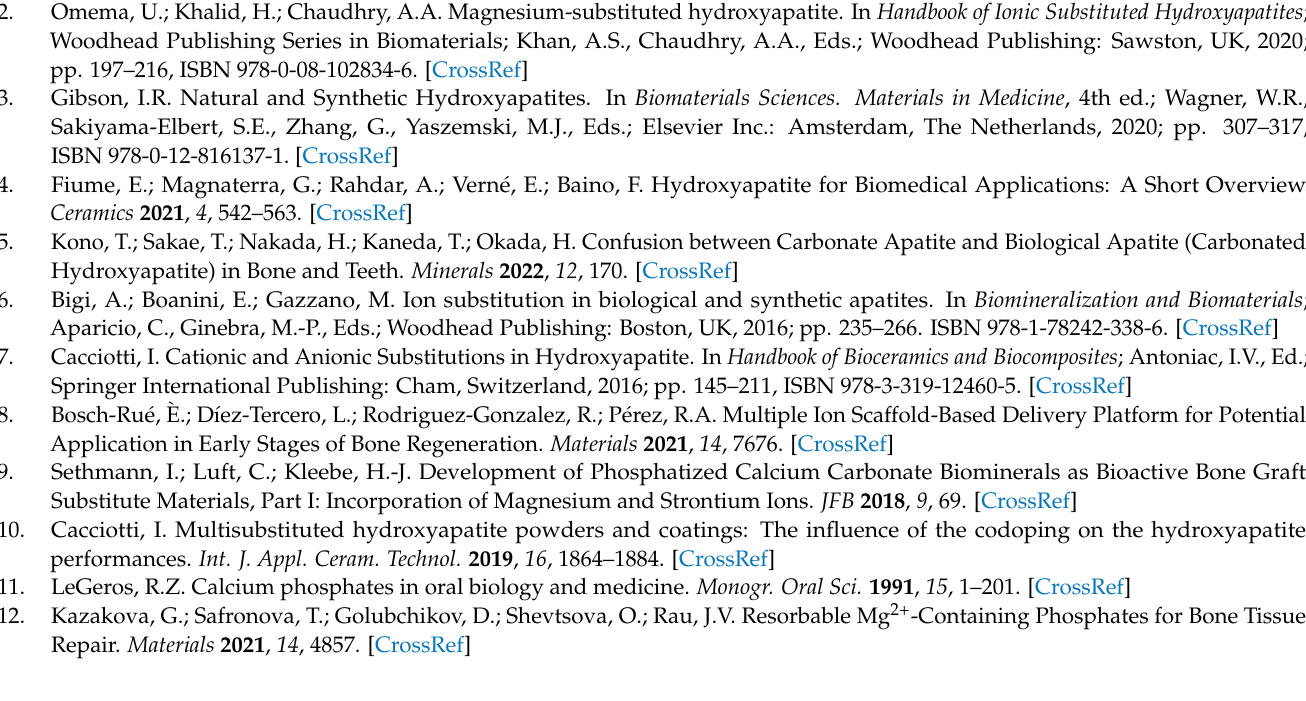
Table S1. Assignation of peaks in PXRD patterns of hydroxyapatite; Table S2. Assignation of IR bands in FTIR spectra of hydroxyapatite; Table S3. Assignation of peaks in PXRD patterns of Mg-substituted hydroxyapatite; Table S4. Assignation of IR bands in FTIR spectra of Mg-substituted